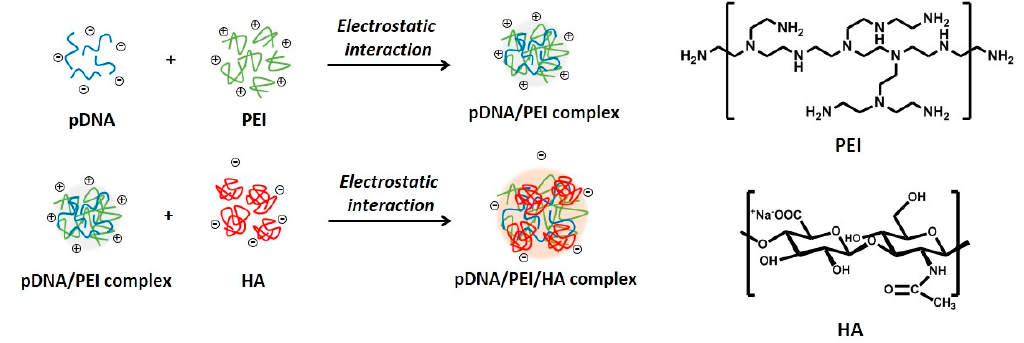
Figure 1. Schematic illustrations for the synthesis of electrostatically self-assembled pDNA/PEI/HA ternary nanocomplexes (pDNA ( blue line ): plasmid DNA, PEI ( green line ): polyethylenimine, HA ( red line ): hyaluronic acid).